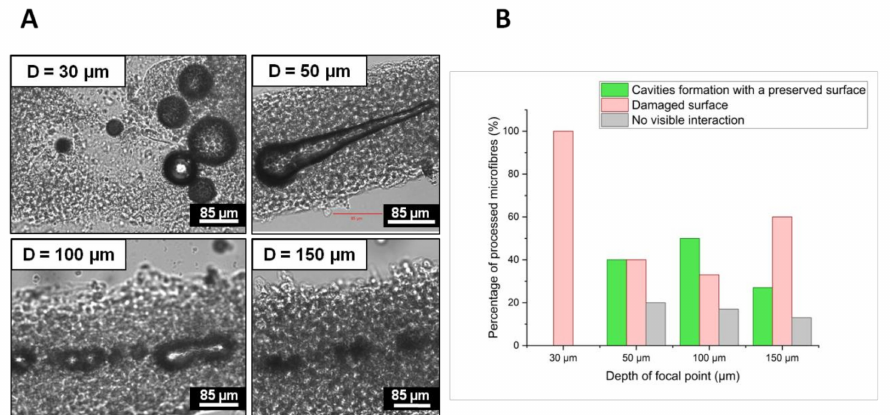
Figure 1. ( A ) CCD camera images of cavitation bubbles recorded 5s after laser processing and observed inside four different microfibres processed with the same laser parameter and four different depths of focus: D = 30 µ m, 50 µ m, 100 µ m, and 150 µ m. Cavitation bubbles were imaged in the collagen hydrogel core at the processing depth. Fixed process parameters: λ = 1030 nm; F = 22.1 J/cm 2 ; R.R. = 50 kHz; O.L. = 99.7%; two consecutive laser passes. ( B ) Evolution of the microfibre number (%) with respect to the type of laser-induced modifications observed 24h after laser processing for different depths of